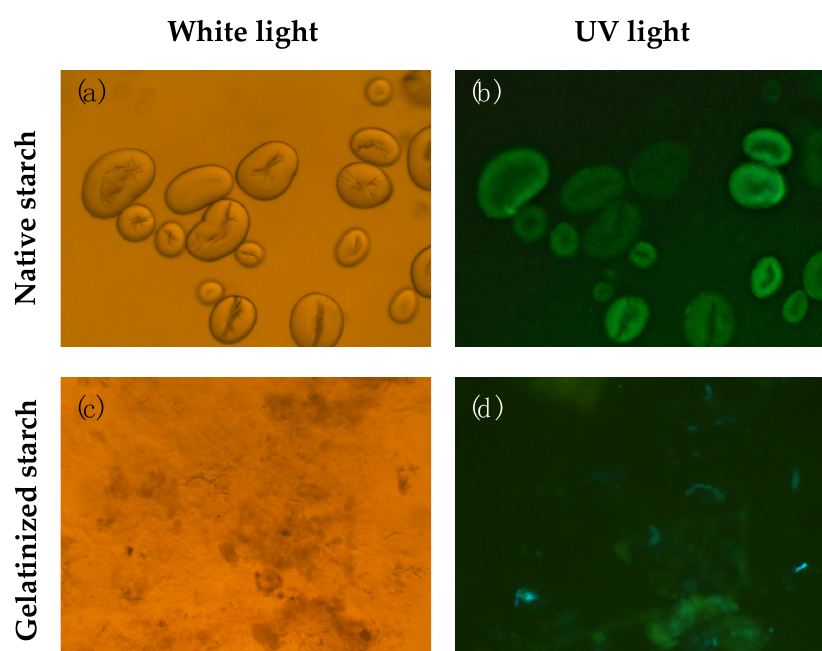
Figure 2. Microscopic images of native and gelatinized Borlotti bean starch with the same frame, observed under white and UV light illumination (280 nm). Starch granules isolated from Borlotti beans observed under white light illumination with phase contrast (a) and observed under UV light (b) indicating the localization of polyphenols or other fluorescent molecules within the granules. The starch granule structure is lost after gelatinization (c) florescence is still observed in gelatinized starch aggregates (d). Table 2. HPLC-MS analysis of cooked Borlotti bean extract.